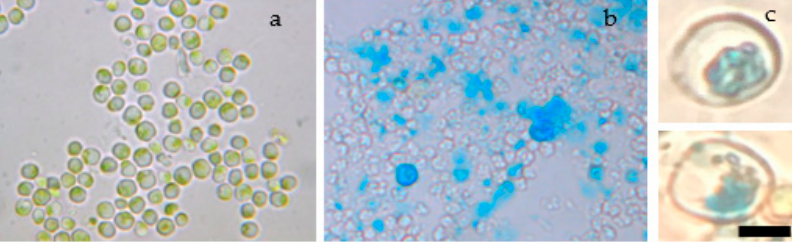
Figure 6. Prussian blue staining. ( a ) Nonelectroporated cells stained with Prussian blue. ( b ) Low magnification (40 × ) of electroporated cells stained with Prussian blue. ( c ) High magnification (100 × ) of electroporated cells stained with Prussian blue, which turns blue in the presence of iron inside cells. Bar size: 5 μ m.